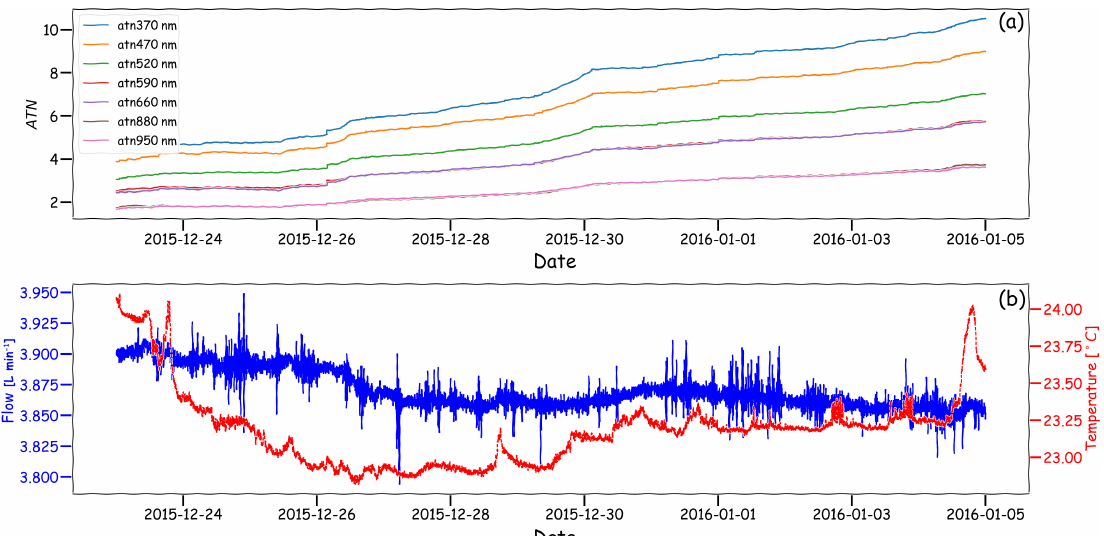
Figure A1. Time series of (a) ATN for all Aethalometer wavelengths and (b) measured Aethalometer flow rate and room temperature with an external flow meter (TSI Inc 4000